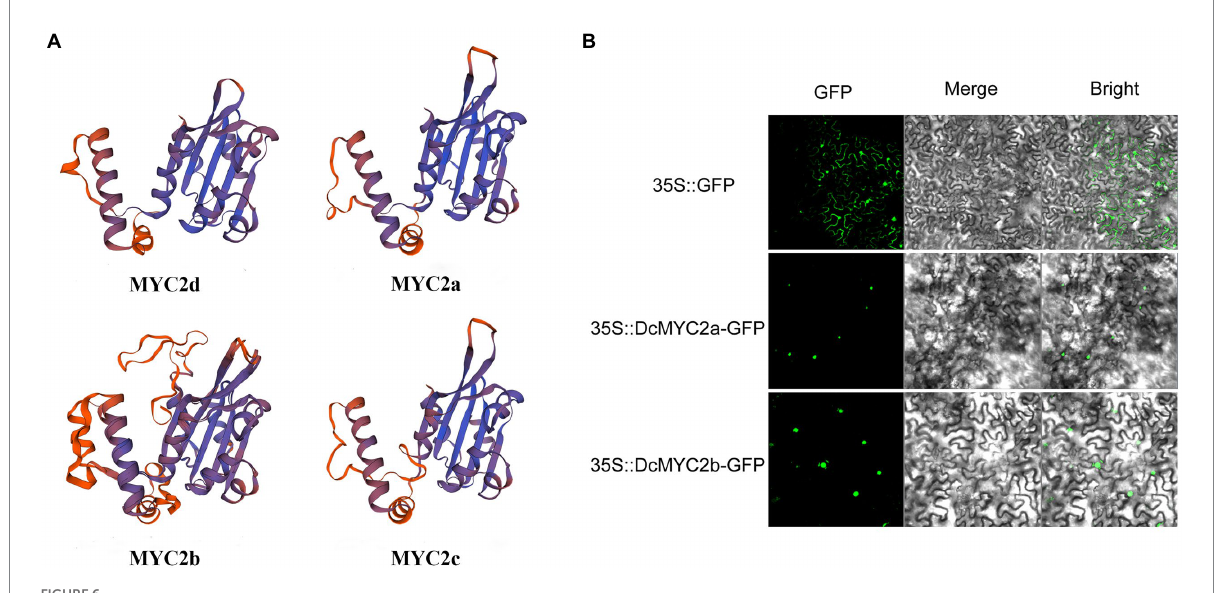
FIGURE 6 Prediction model of protein tertiary structure of subgroup IIIe members and subcellular localization. (A) Protein tertiary structure of DcMYC2a/2b/2c/2d. (B) Subcellular localization of DcMYC2a/2b in tobacco